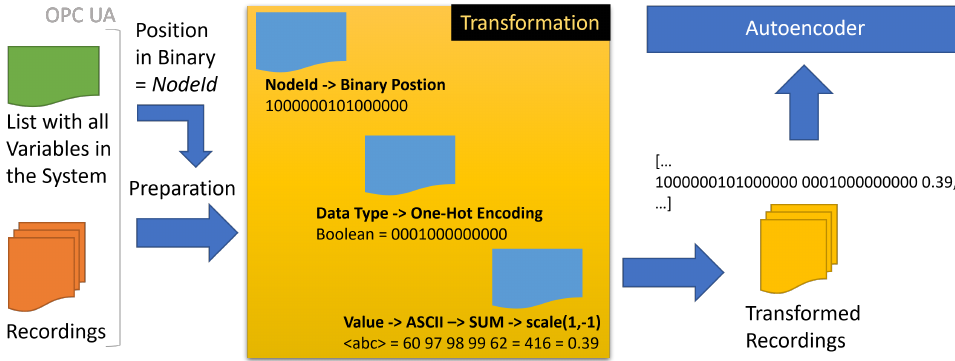
Figure 5. The transformation process. Numerical transformation of recorded